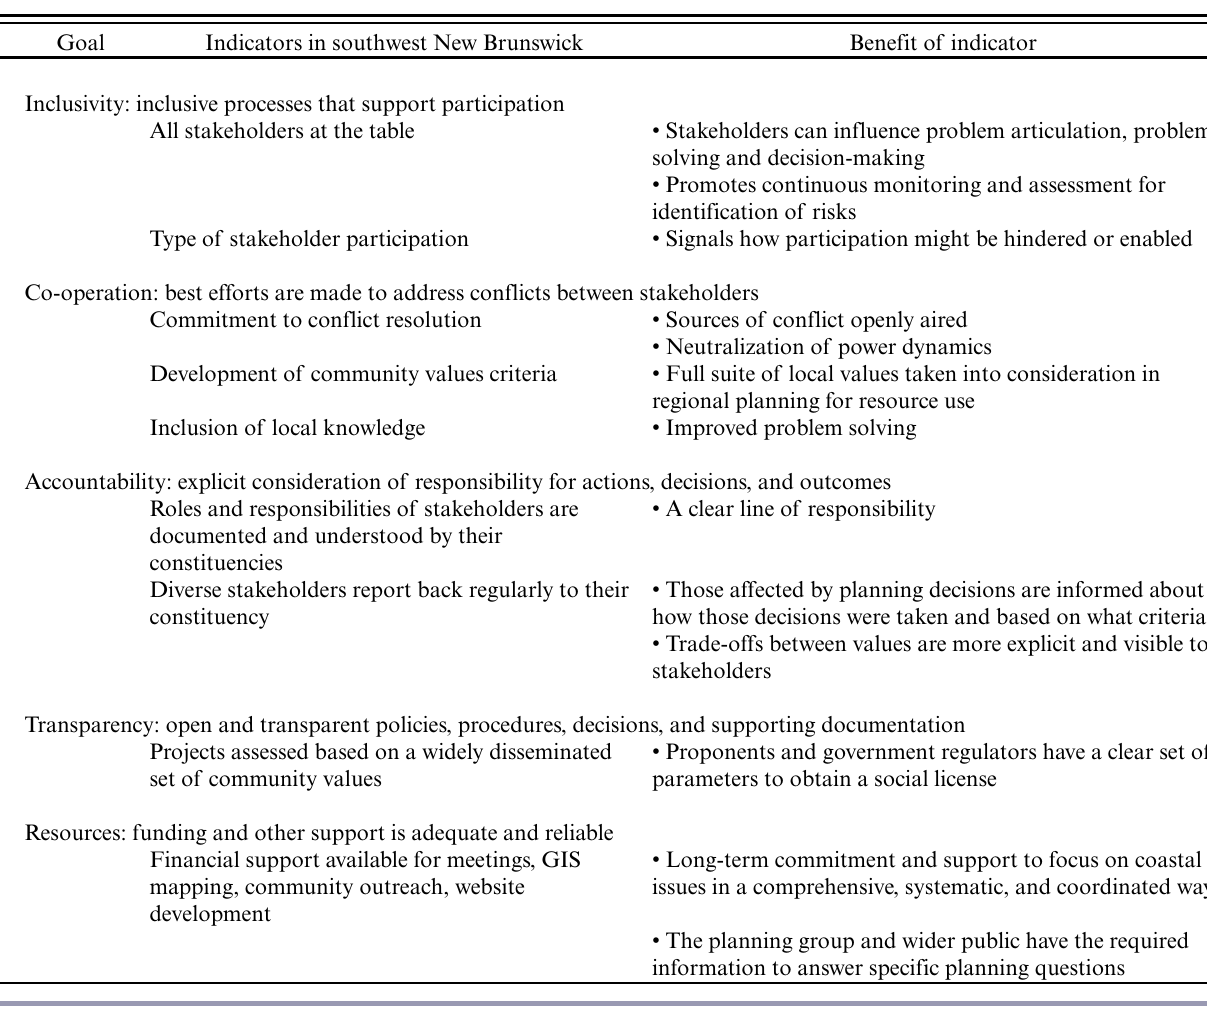
Table 1. Proposed institutional indicators from the Canadian Fisheries Research Network sustainability framework based on this study’s